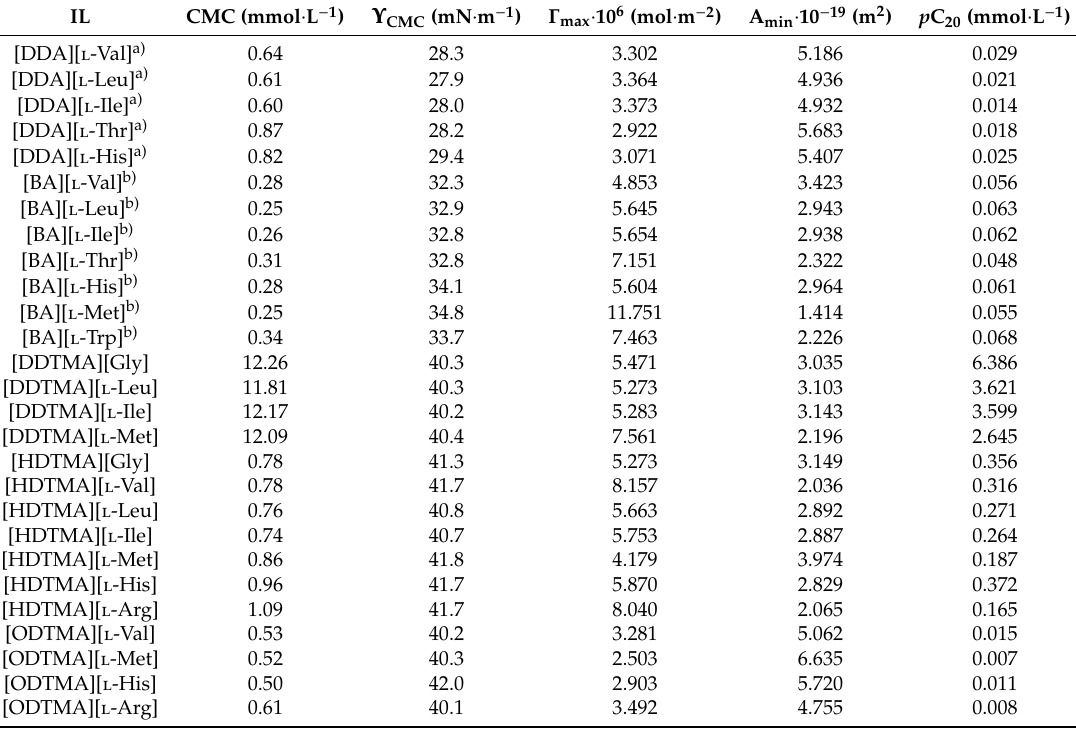
Table 5. Critical micellar concentration (CMC), surface tension ( σ CMC ), surface excess concentration ( Γ max ), and area per molecule (A min ) of the prepared ILs in aqueous solution at 25 ◦ C.